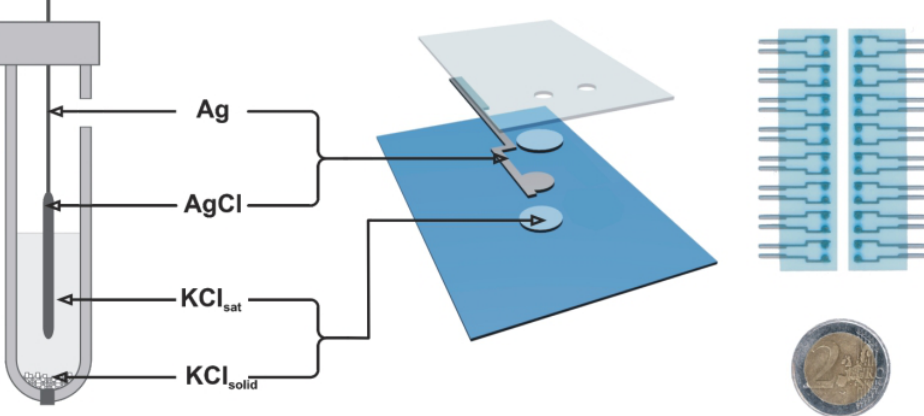
Figure 6. Structure of a conventional reference electrode of Ag/AgCl/KCl type (left) and design of a planar reference electrode fabricated by means of screen-printing (middle, right). Photo of obtained electrodes with 2 Euro coin (for describing scale) is also